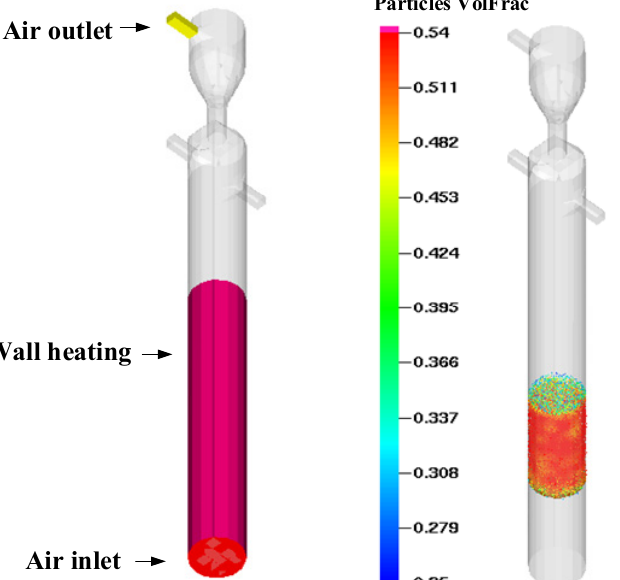
Figure 4. Initial settings.